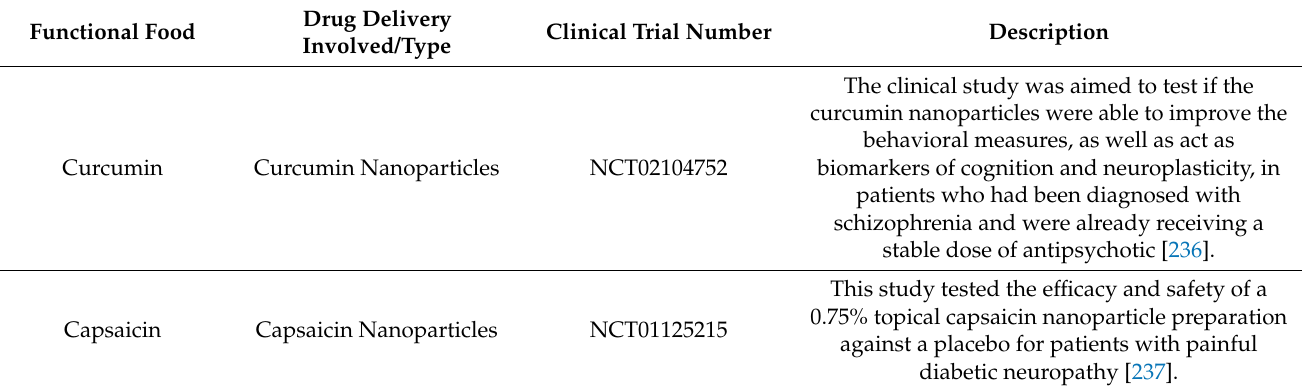
Table 3. Notable clinical trials involving common functional foods on various diseases.